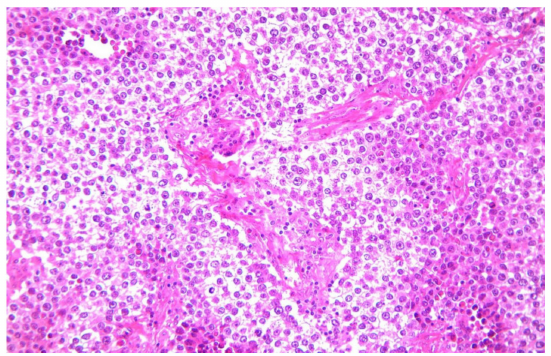
Figure 3. Nests of large, uniform polygonal cells with clear or eosinophilic cytoplasm, separated by fibrous septae, containing lymphocytes (20 × HE) (courtesy of Dr. R. Chirculescu).